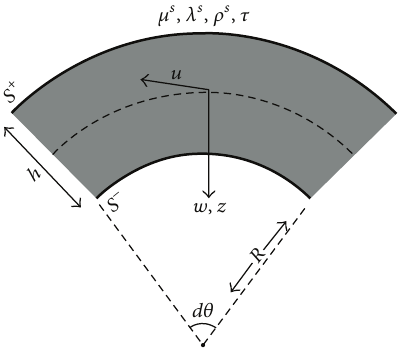
Figure 1: Geometry of an element of a circular curved nanobeam with surface